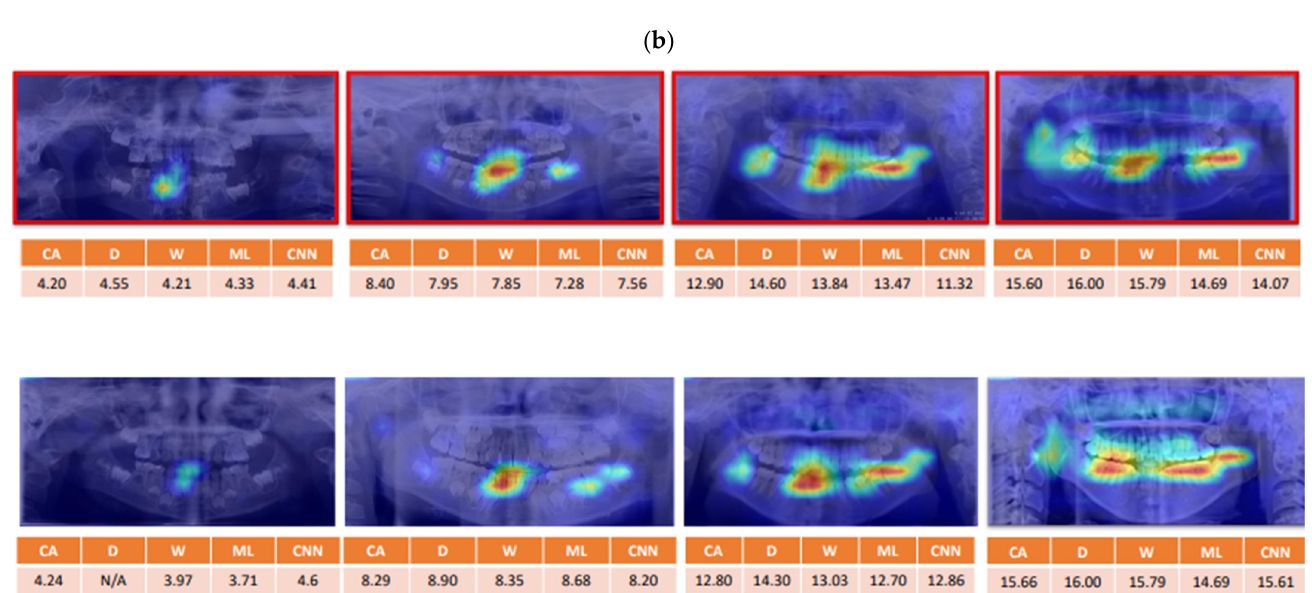
Figure 1. The feature identification of the convolutional neural network (CNN) models in samples. The comparison of the identified features by the CNN models between the healthy children and children with growth delay (GD) at the same age (( a ) boys, ( b ) girls). The images of GD children are framed in red color. The coloring indicated the order of the increased intensity of attention from blue, green, yellow to red. The area and intensity of the feature identification in the GD children are relatively delayed compared to that of healthy ones. Abbreviations: chronological age (CA), D method (D), W method (W), machine learning (ML), convolutional neural network (CNN).